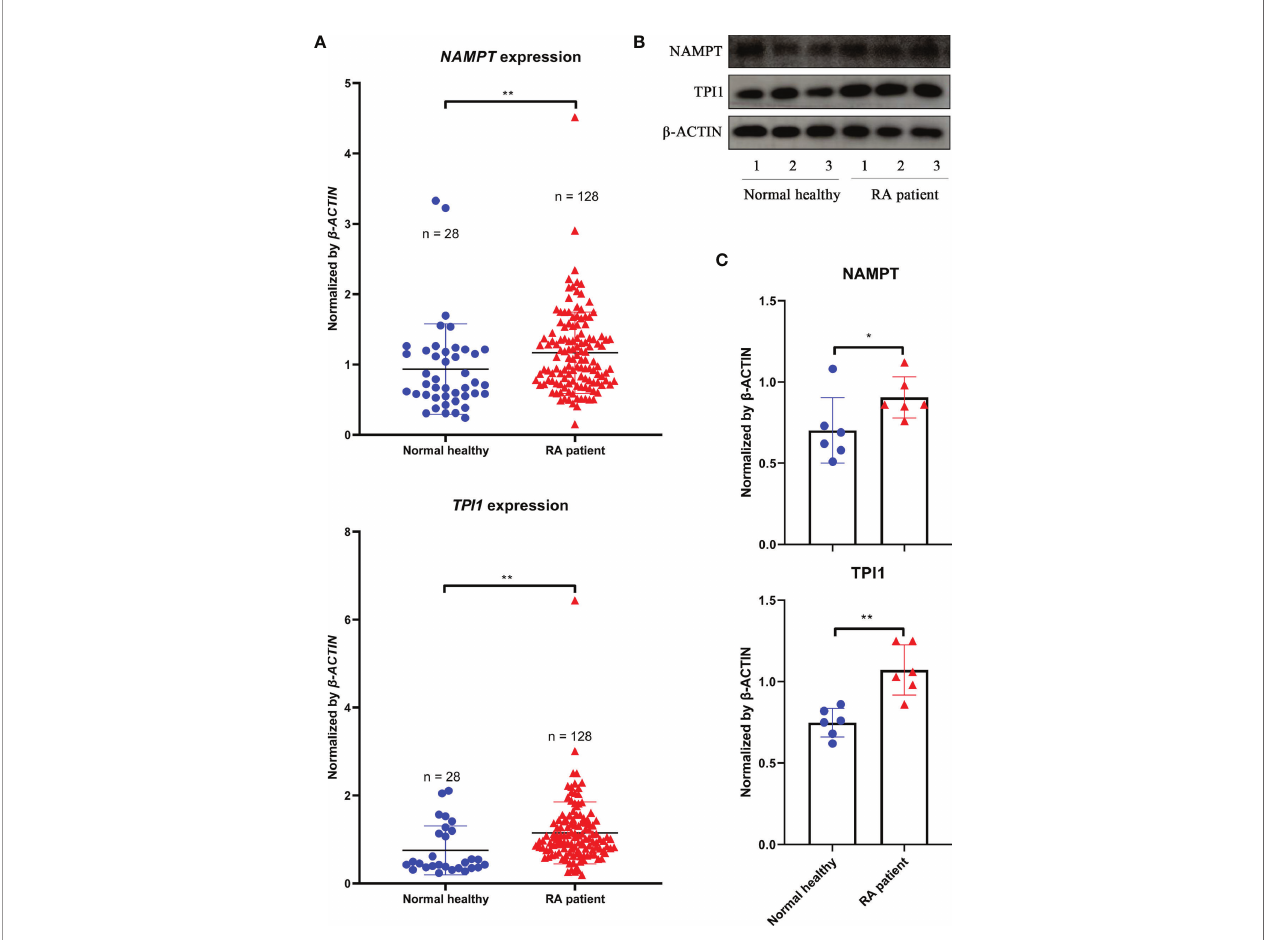
FIGURE 6 | Differences of NAMPT and TPI1 levels between RA patients and general population. (A) , NAMPT and TPI1 expression in WBCs samples; (B) , representative image of immunobloting assays evaluating NAMPT and TPI1 levels in WBCs isolated from RA patients and healthy volunteers; (C) , quanti fi cation results of immunobloting assay. The statistical signi fi cance p values < 0.05* or 0.01** were calculated between groups matched by